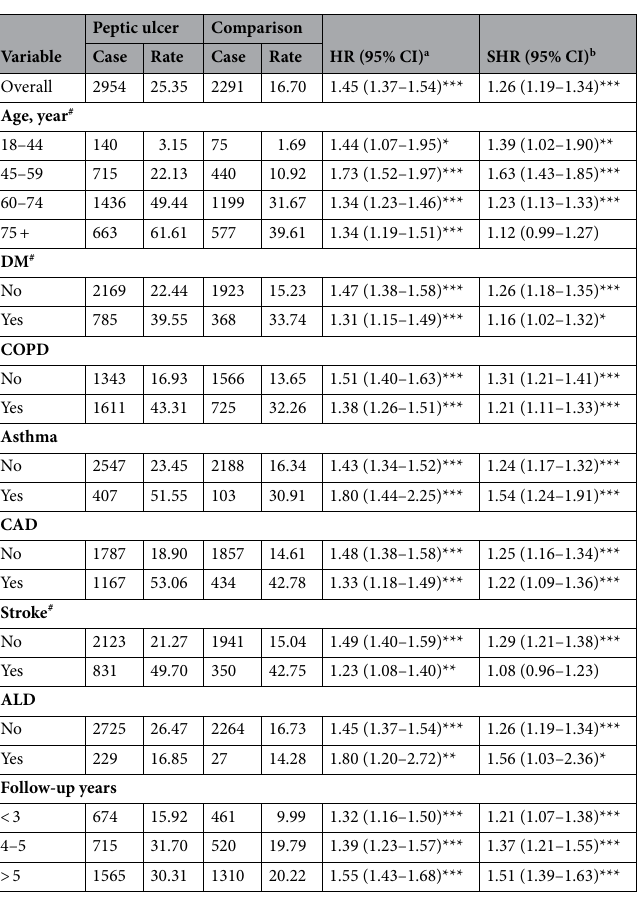
Table 2. Incidence and Cox proportional hazards regression method estimated hazard ratio of BPH by sex, age, comorbidity and follow-up. Rate, per 1000 person-years. ALD alcohol-related disease, BPH benign prostatic hyperplasia, CAD coronary artery disease, CI confidence interval, COPD chronic obstructive pulmonary disease, DM diabetes mellitus, HR hazard ratio, SHR subdistribution hazard ratio. # Interaction p < 0.05 in model 1. Cox proportiona assumption test, p = 0.003. *p < 0.05, **p < 0.01, ***p < 0.001. a Using Cox proportional hazard regression after adjustingd for age, and all comorbidity. b Using Cox proportional hazard regression with competing risk (death) after adjusting for age, and all